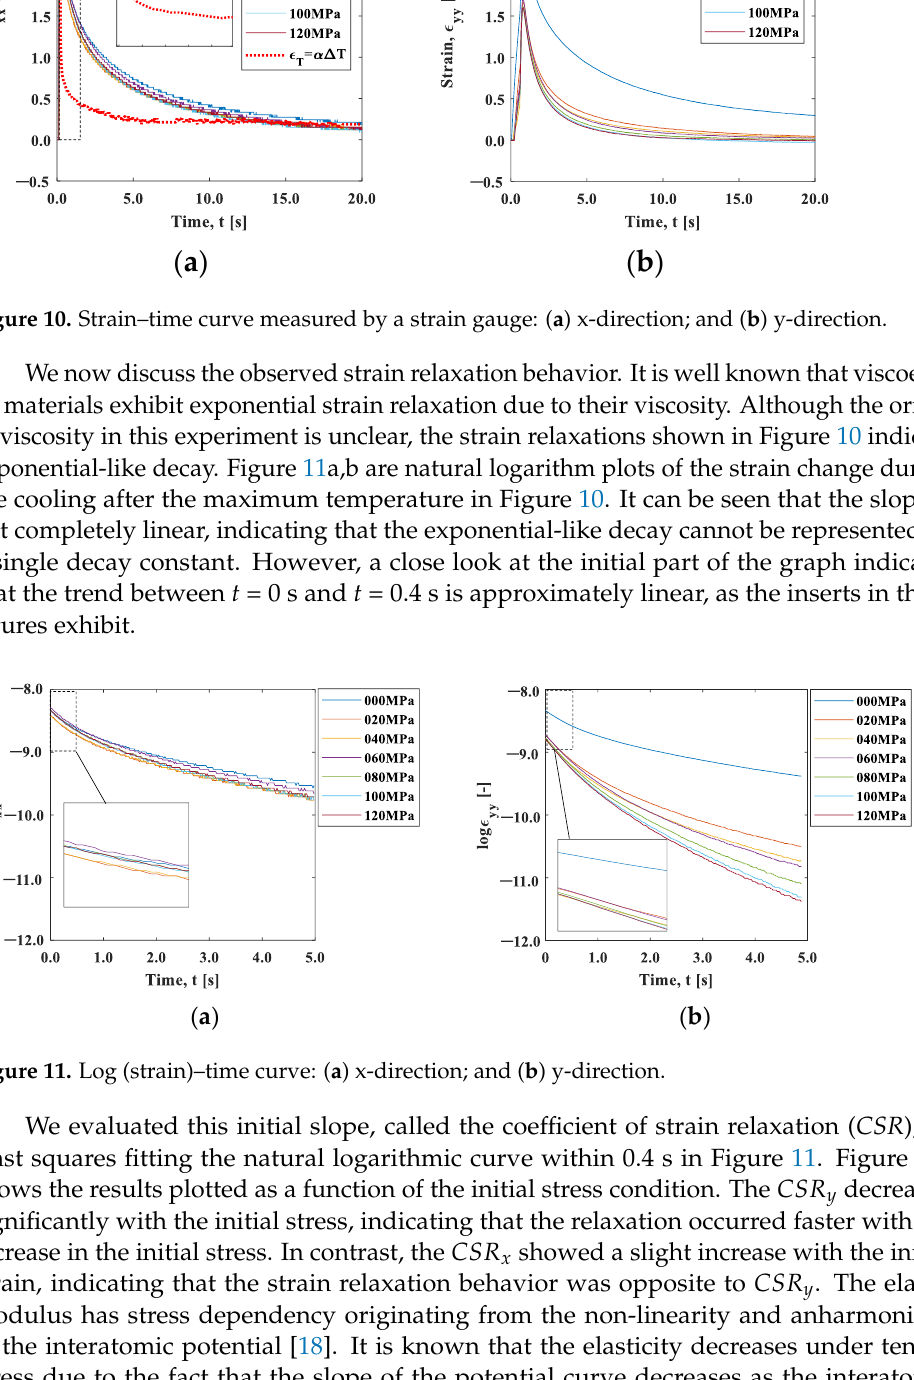
strain measurement.